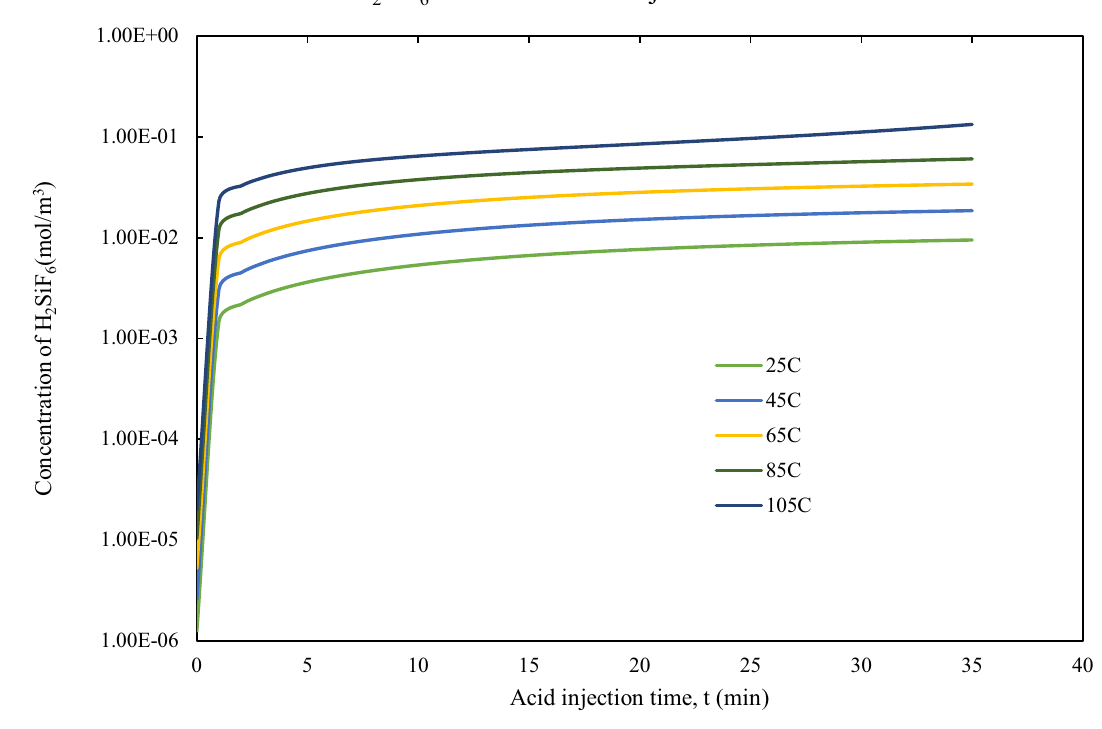
Fig. 15 The effect of temperatures on H 2 SiF 6 concentration along acid injection time